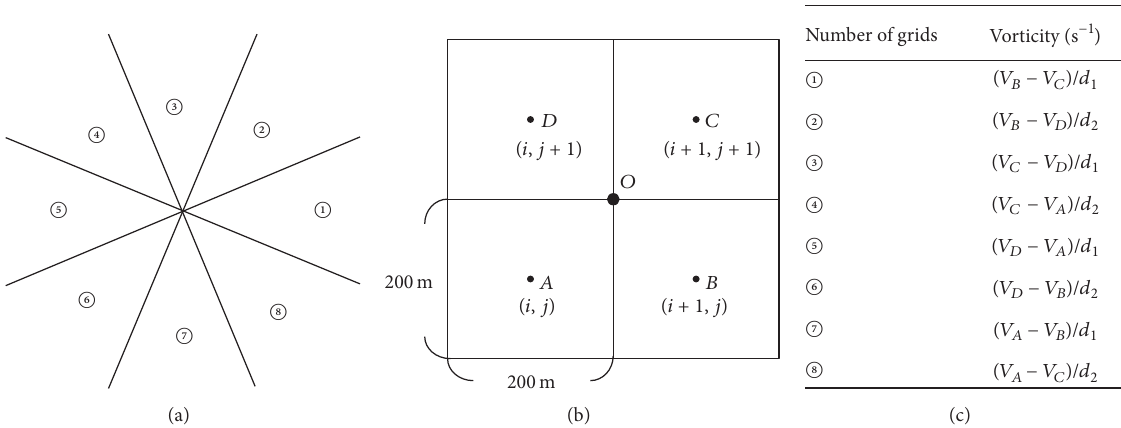
Figure 7: (a) Eight-direction map from the radar site, (b) grid number and corresponding formulas for vorticity calculations, and (c) vorticity estimation method for each direction.